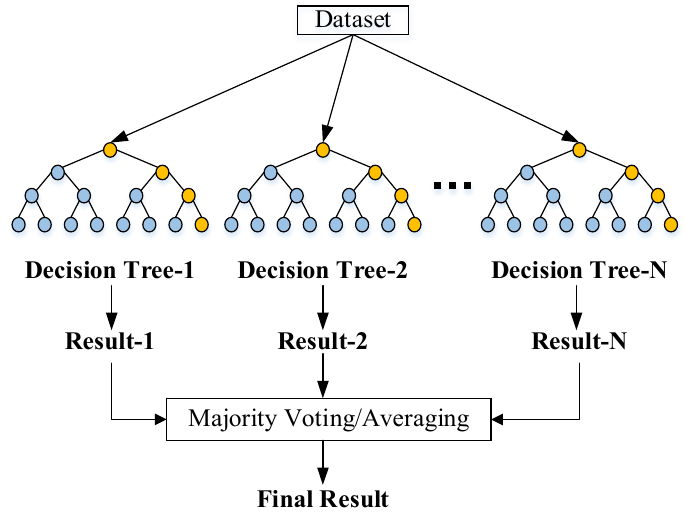
Figure 5. Flow chart of RF algorithm.